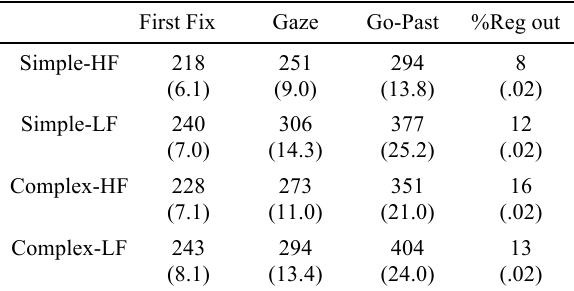
Region 4 was the remainder of the sentence;